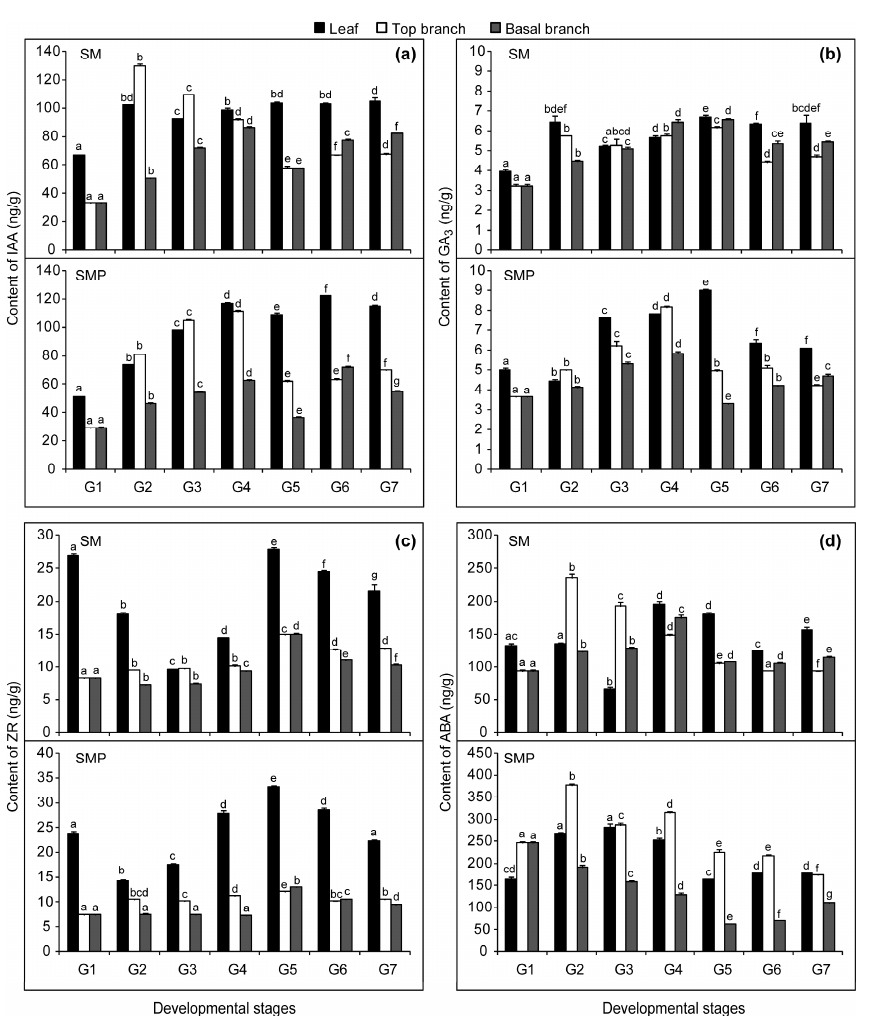
Figure 2. Changes in endogenous hormone content during different developmental stages and in tissues: ( a ) indole acetic acid (IAA); ( b ) gibberellic acid (GA 3 ); ( c ) zeatin riboside (ZR) and ( d ) abscisic acid (ABA). Leaf, top branch, and basal branch represent the three tissues, and G1-G7 represent the seven developmental stages. SM, S. matsudana ; SMP, S. matsudana var. pseudo-matsudana . Hormone concentrations in fresh weight. Bars represent SE (n = 9). Different letters on columns with the same pattern indicate differences at P <0.05 according to the LSD test.